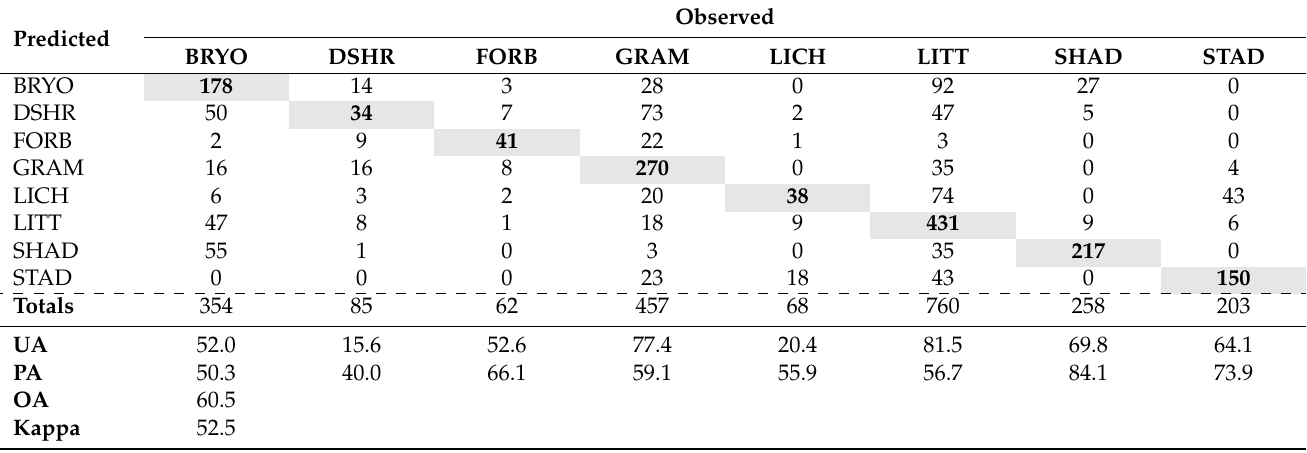
Table 2. Thematic accuracy of the final random forest model on the test data set. Overall accuracy (OA) is calculated from the bolded diagonal values along the confusion matrix, which indicate the number of image objects that were correctly classified. Kappa accounts for the possibility of agreement between the reference and classified data sets based on chance. Individual class accuracy is analyzed by producer accuracy and user accuracy. Producer accuracy (PA) describes the probability that a real-life object is classified correctly in the image, whereas user accuracy (UA) describes the probability that a classified object in an image matches the object in real-life. Bryophytes = BRYO; Deciduous Shrubs = DSHR; Forbs = FORB; Graminoids = GRAM; Lichens = LICH; Litter = LITT; Shadow = SHAD; Standing Dead = STAD.